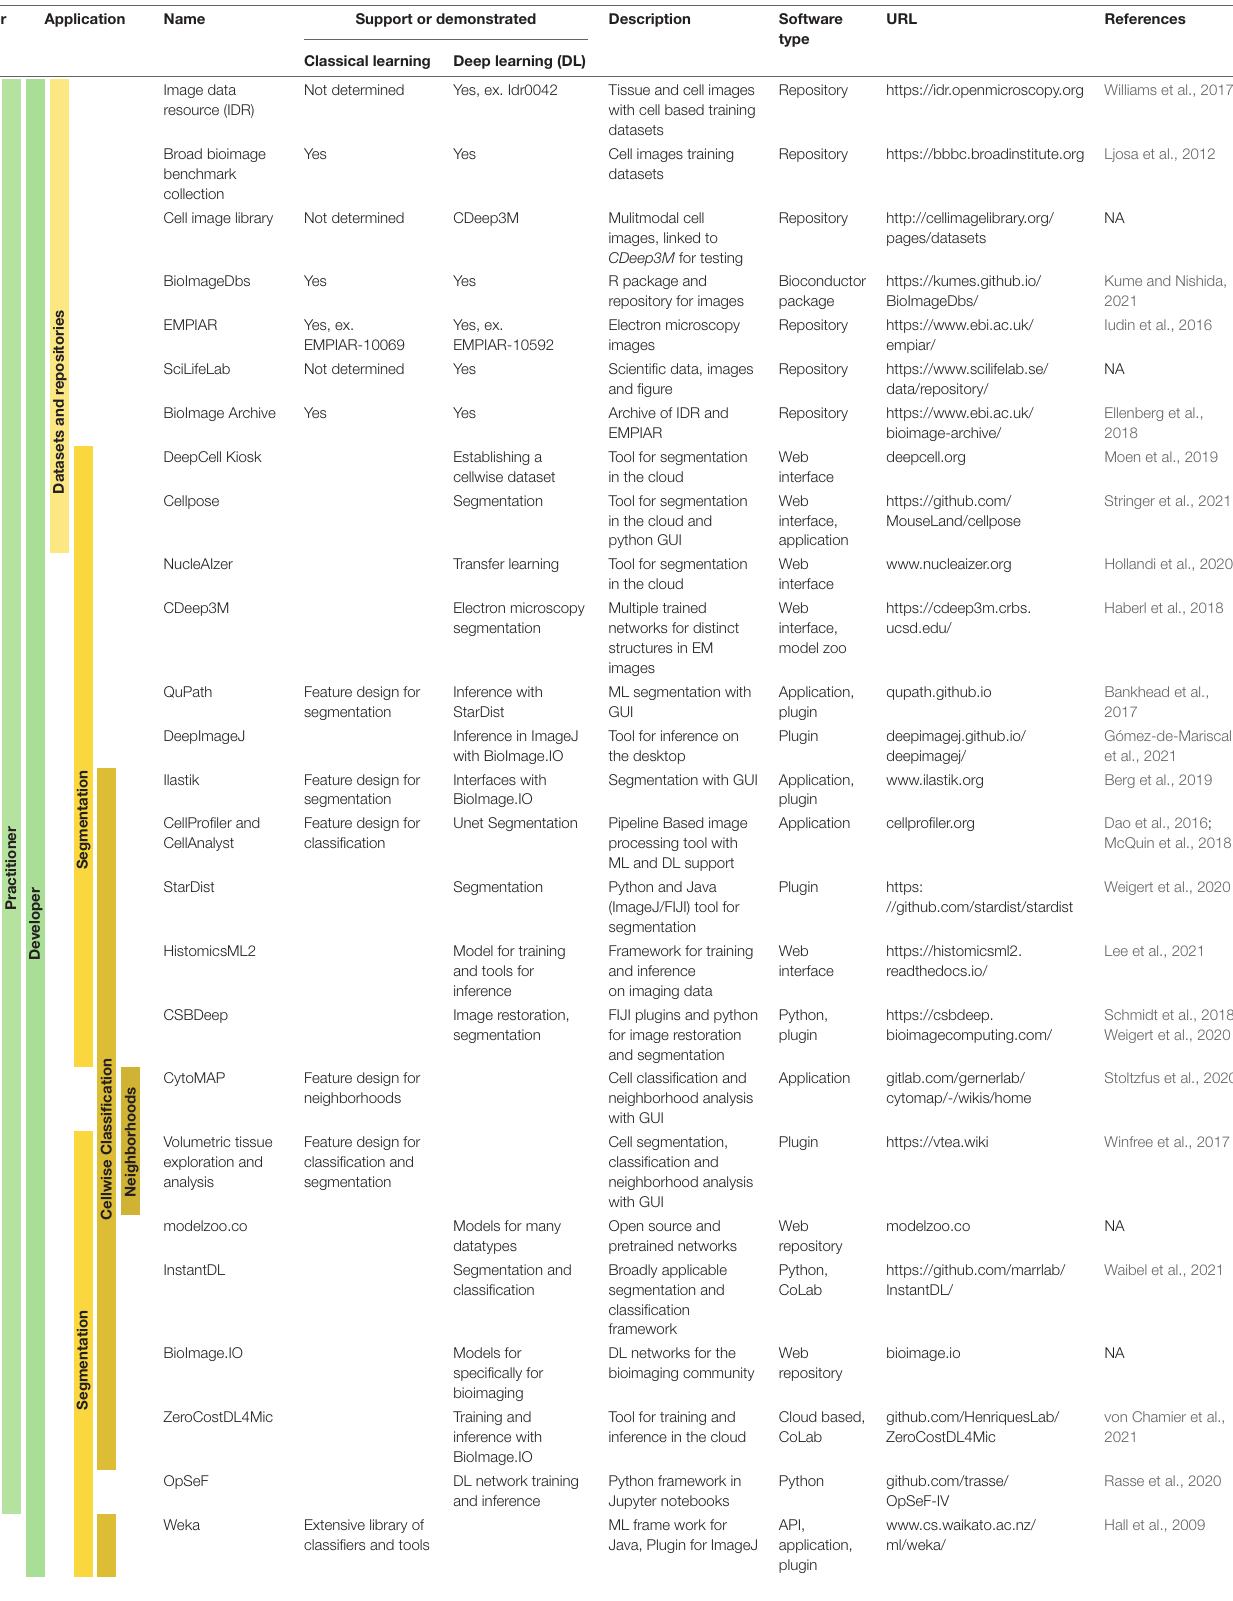
TABLE 1 | End user accessibility of tools supporting machine and/or deep learning for bioimage analysis. User